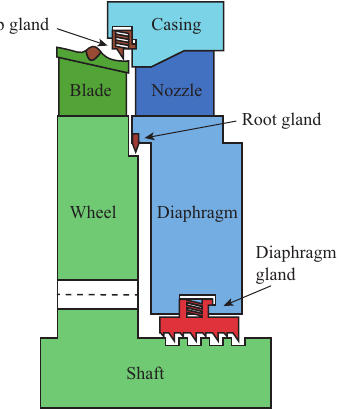
Figure 4. Interstage glands of the steam